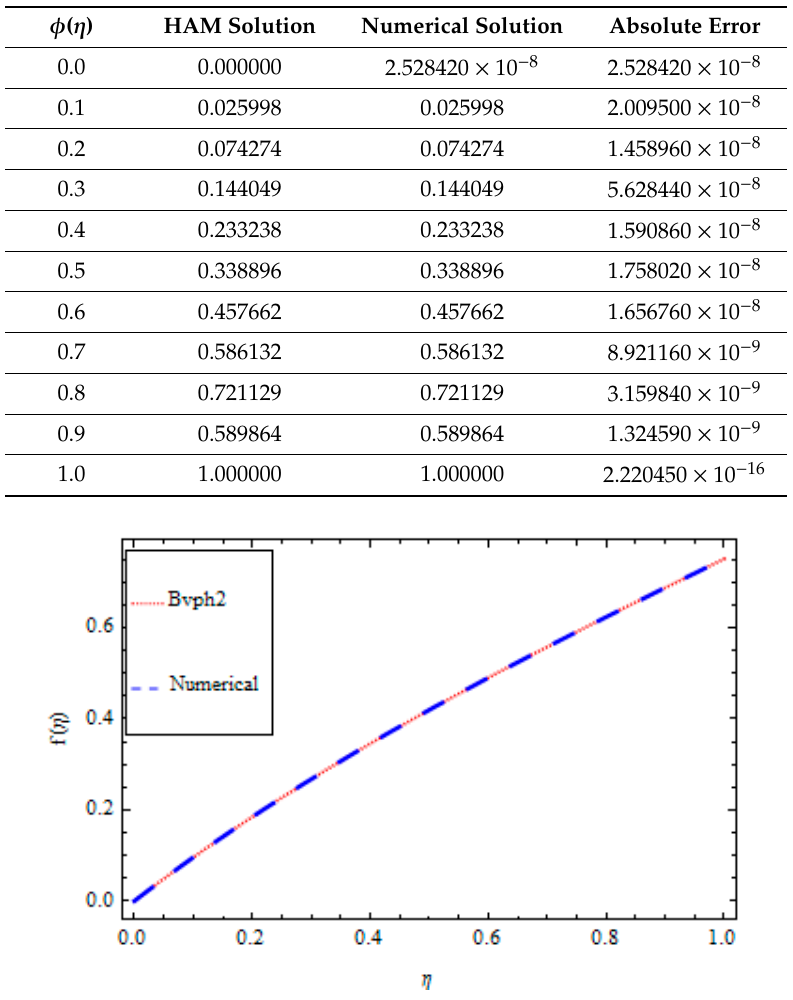
Table 6. Comparisons of the HAM and numerical solution.